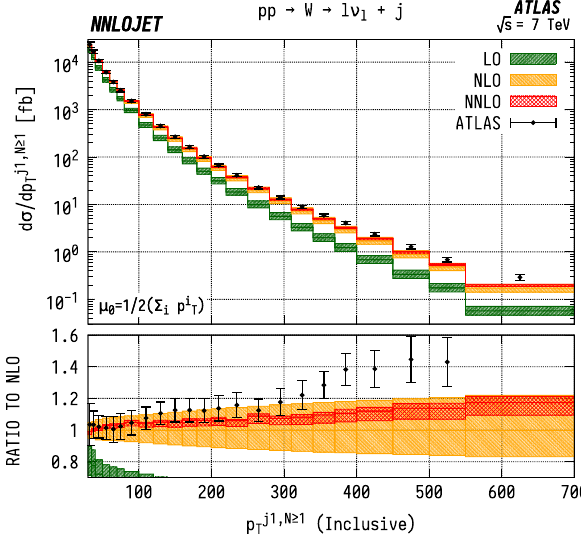
Fig. 16 WJ cross section differential in the transverse momentum p T of the leading jet for events with one or more associated jets ( N ≥ 1 ) . See Fig. 14 for details